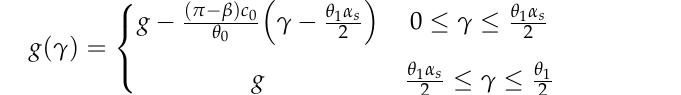
where c 0 is the opening of the claw pole slot in meters, θ 1 is the slot pitch in radians, θ 0 is the slot opening in radians, α s is the slot opening coefficient equal to the ratio of slot opening to slot pitch ( α s = θ 0 / θ 1 ), and β is the angle between the side of the CPT and the bottom of the slot.